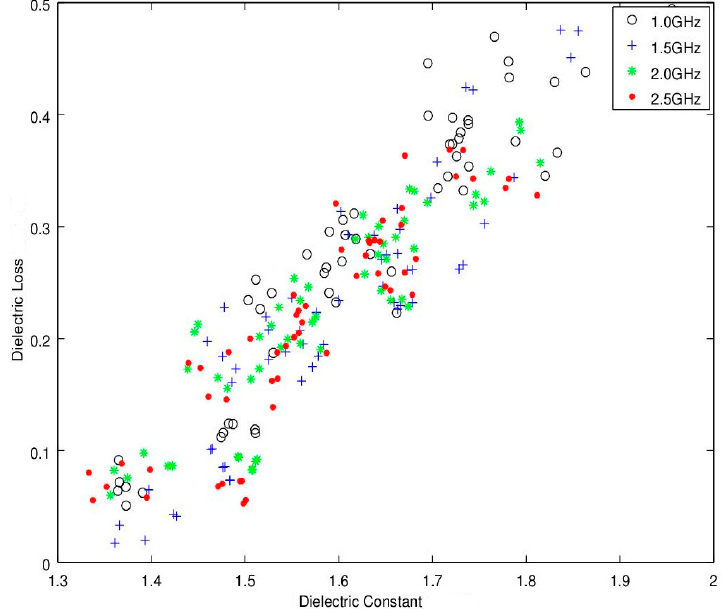
Figure 6. Picture illustrates the Cole-Cole response for several frequencies from 1.0 to 2.5 GHz ( ε ’ versus ε ”). Over this narrow of a frequency range, only a small section of the Cole-Cole ellipse is represented.